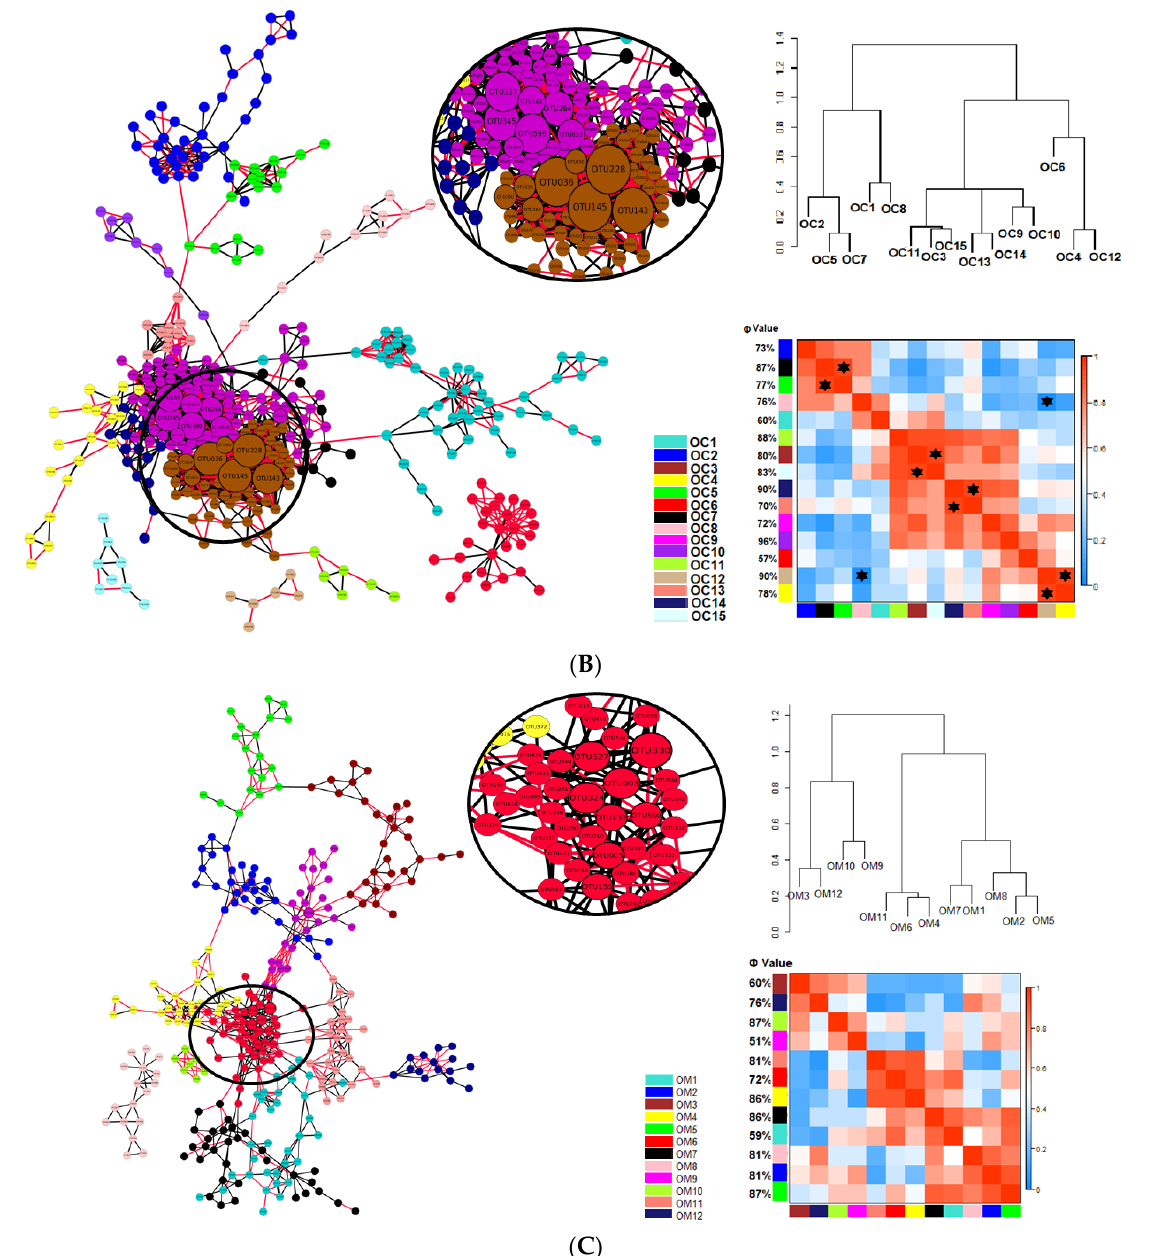
Figure 1. Networks of ( A ) the conventional cropping system (Conv) and both organic cropping systems, ( B ) Org_C and ( C ) Org_M, based on OTU profiles. On the top right a hierarchical clustering is shown based on Pearson correlations among module eigengenes. Below the clustering, a heatmap shows the coefficient values. The color red means higher correlation, while blue signifies lower correlation. Modules smaller than five nodes were excluded from eigengene analysis and are not displayed. Modules larger than five nodes are labelled with different colors in the network. The size of the circle is directly proportional to the number of edges in the module, and a large circle implies a higher number of connections in the node. Red and black lines represent negative and positive edges, respectively. A black star on the heatmap ( )indicates a significant ( p < 0.05) correlation among modules: Conv, conventional cropping system; Org_C, organic cropping system with compost and compost tea; Org_M, organic cropping system with manure.